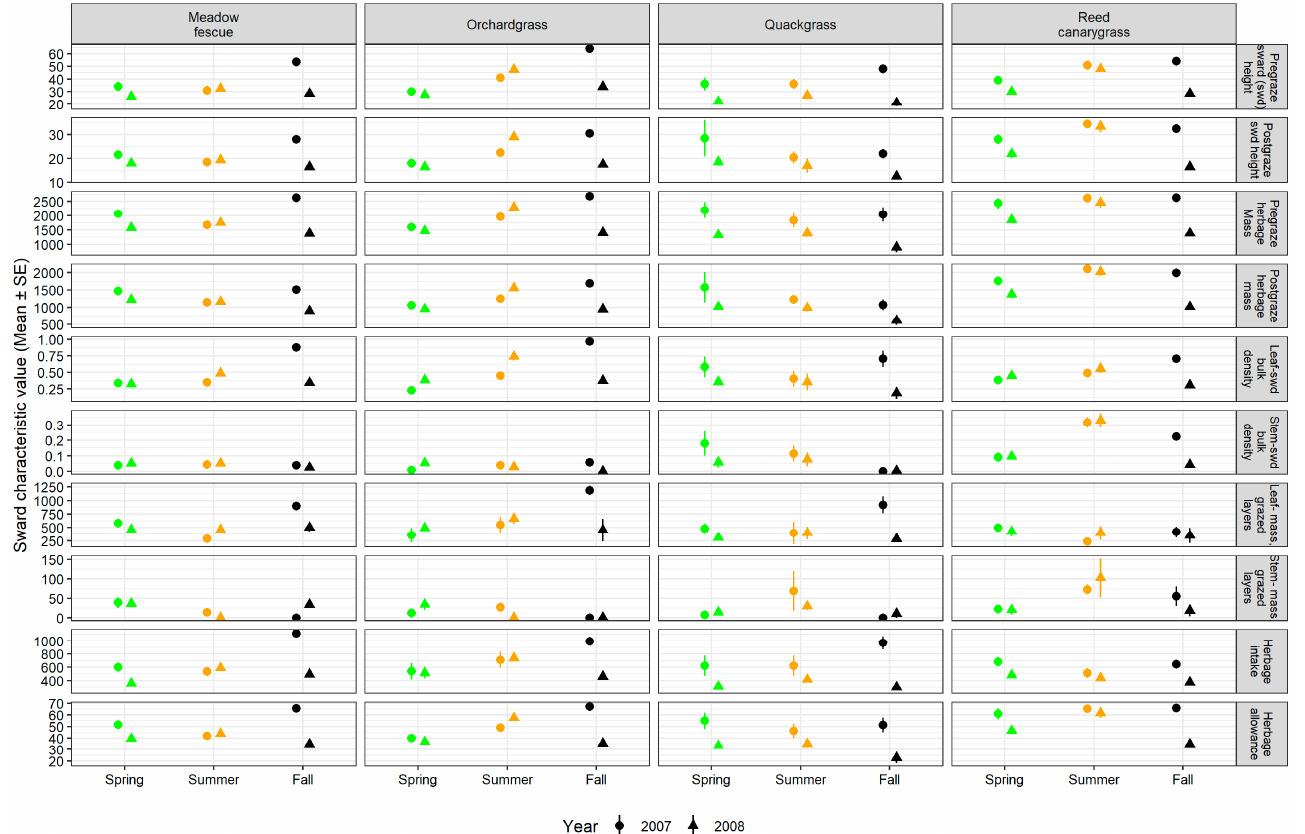
Figure 1. Sward height (cm), herbage mass (kg ha − 1 ), sward bulk density (mg DM cm − 3 ), mass of grazed layers (kg DM ha − 1 ), herbage intake (kg DM ha − 1 ), and herbage allowance (kg DM/kg